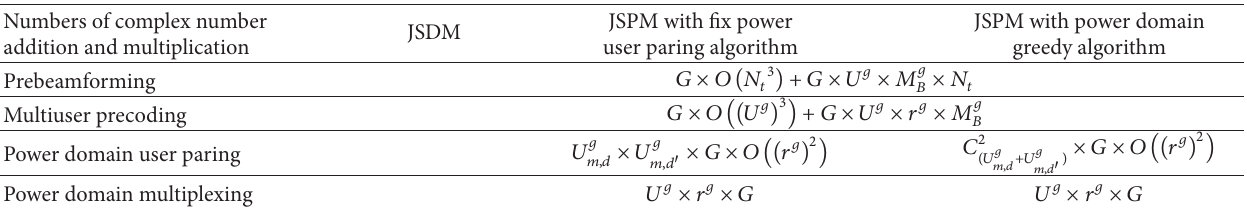
Table 1: Computational complexity